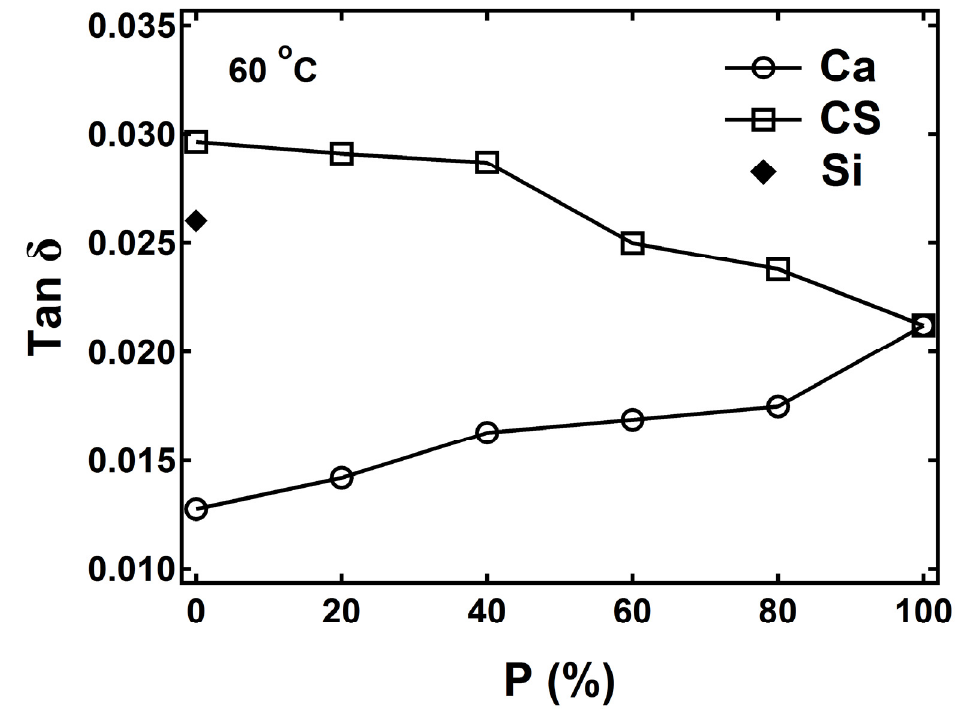
◦ C as predictive performance of rolling Figure 8. Loss tangent at 60 °C as predictive performance of rolling resistance. Figure 8. Loss tangent at 60